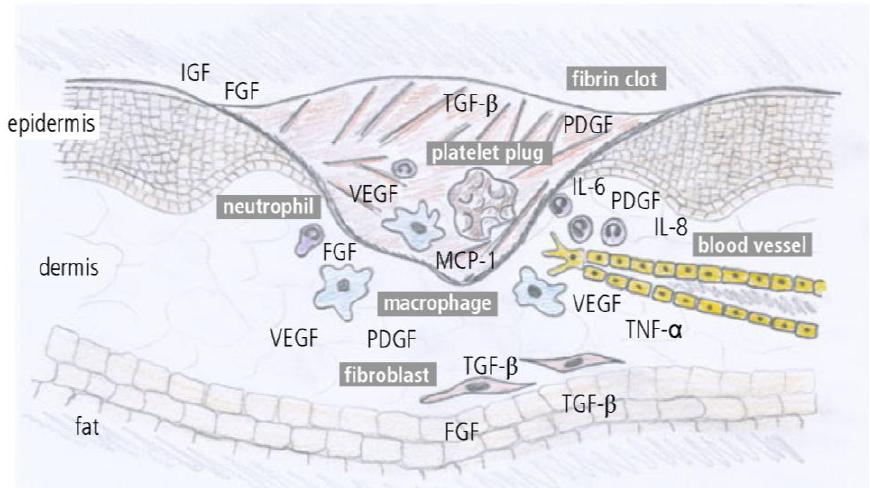
FIGURE 3. Dermal wound healing as an example for the interplay of inflammation and